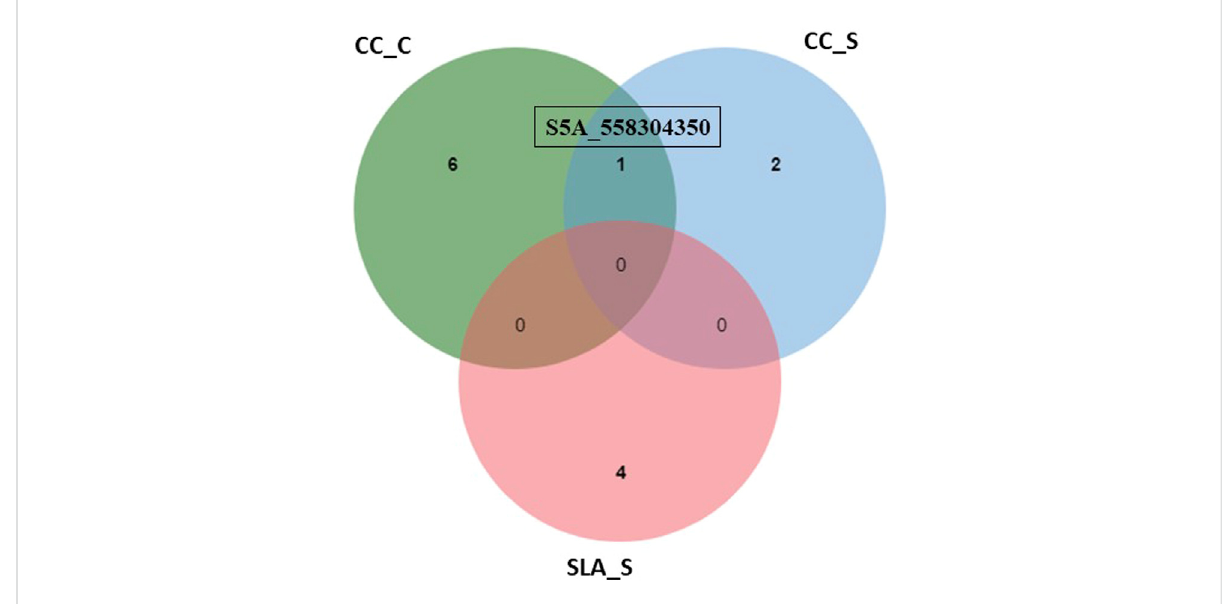
FIGURE 5 Number of individual and common signi fi cant SNPs detected by GWAS for chlorophyll content under control (CC_C), chlorophyll content under salinity (CC_S), and speci fi c leaf area under salinity